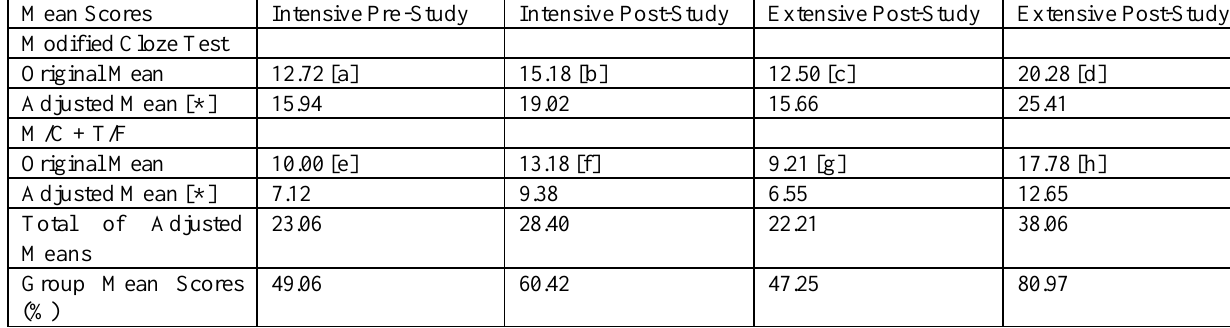
Table 4.13 Adjusted Weightings for Reading Comprehension Test